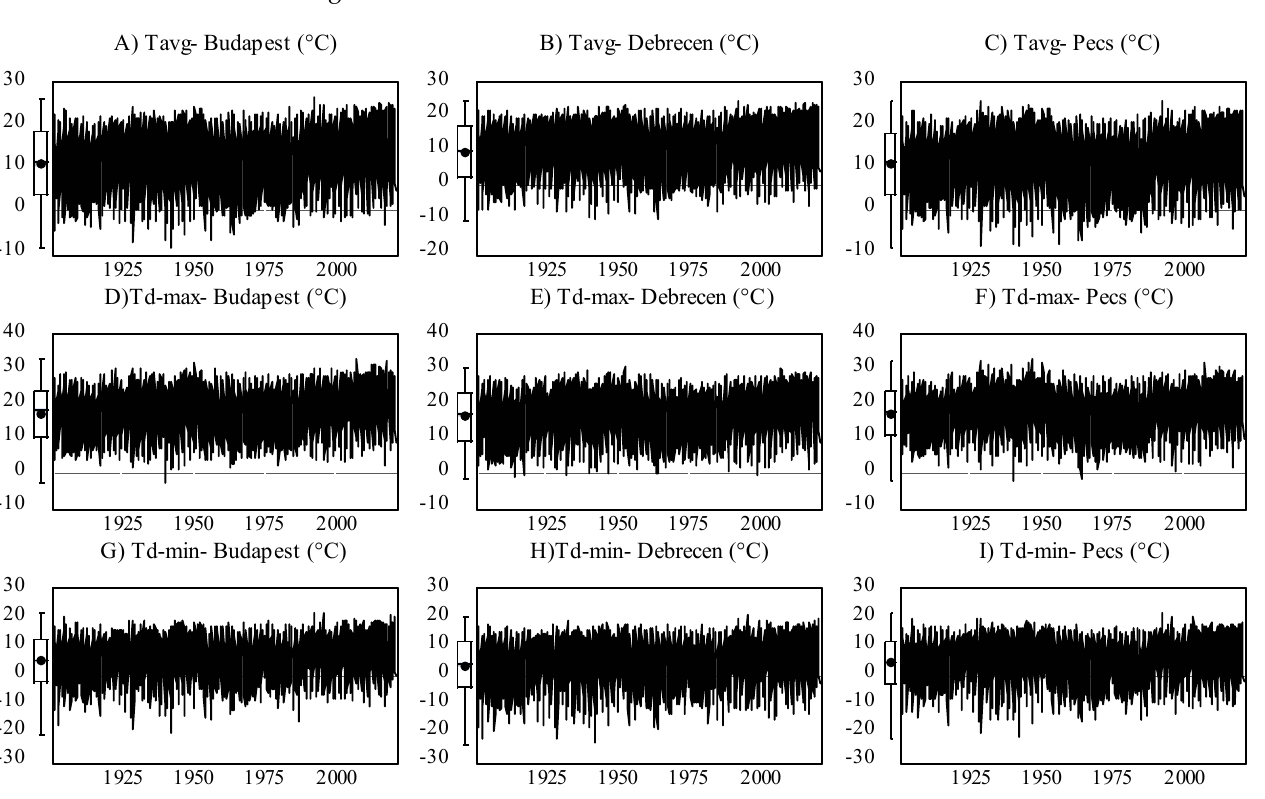
Figure 1. Evolution of monthly mean temperature ( T avg ) ( A – C ), daily maximum mean temperature ( T d-max ) ( D – F ), and daily minimum mean temperature ( T d-min ) ( G – I ) in Central Europe (Budapest, Debrecen, Pécs) between 1901 and 2020.